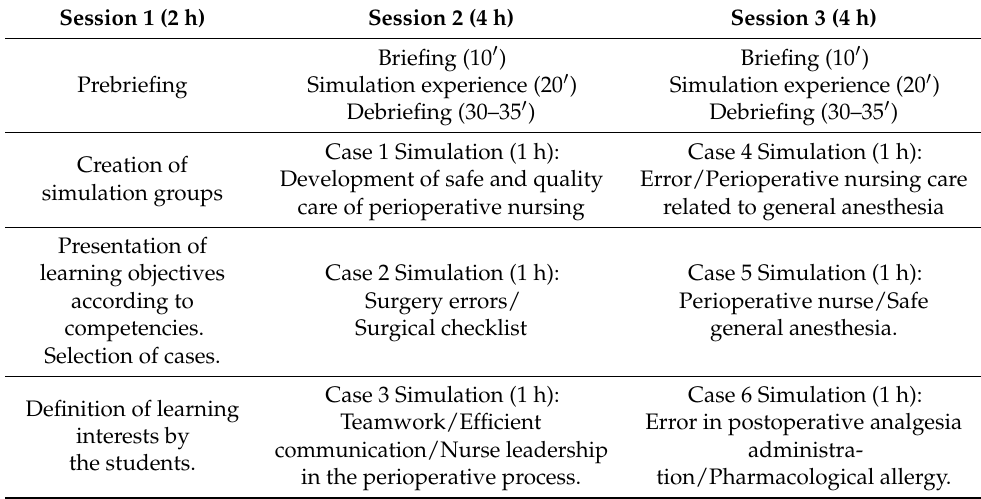
Table 2. Summary of the MAES© simulation